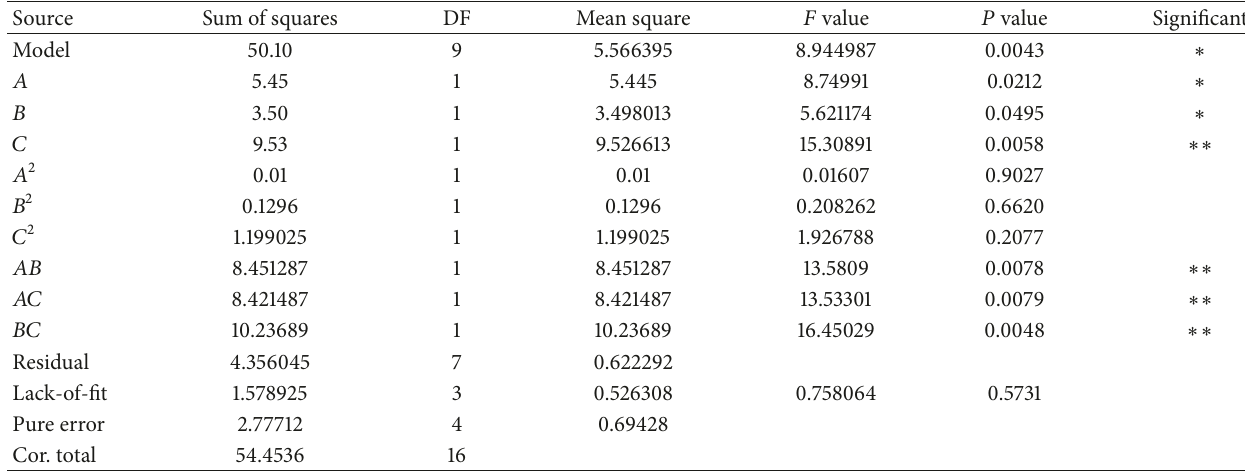
Table 2: ANOVA for response surface quadratic model: analysis of variance table (partial sum of squares). 𝐴 : temperature ( ∘ C), 𝐵 : extraction time (min), and 𝐶 : water-to-material ratio.